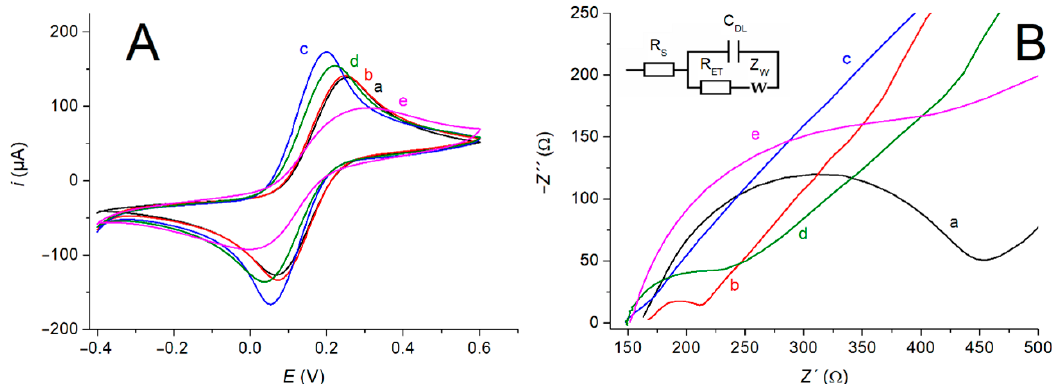
Figure 3. Cyclic voltammograms ( A ) (scan rate = 50 mV/s) and Nyquist plots ( B ) for SPE before ( a ) and after sequential modification with GO ( b ), AuNF ( c ), Apt-ADA ( d ), and casein ( e ), measured in 0.1 M KCl solution containing 5 mM K 3 [Fe(CN) 6 ]/K 4 [Fe(CN) 6 ] (1:1). Inset in ( B ): Randles equivalent circuit.